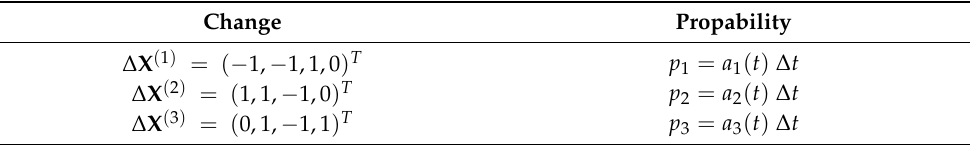
Table 5. Possible change in X = ( X 1 , X 2 , X 3 , X 4 ) T and their probabilities. Change